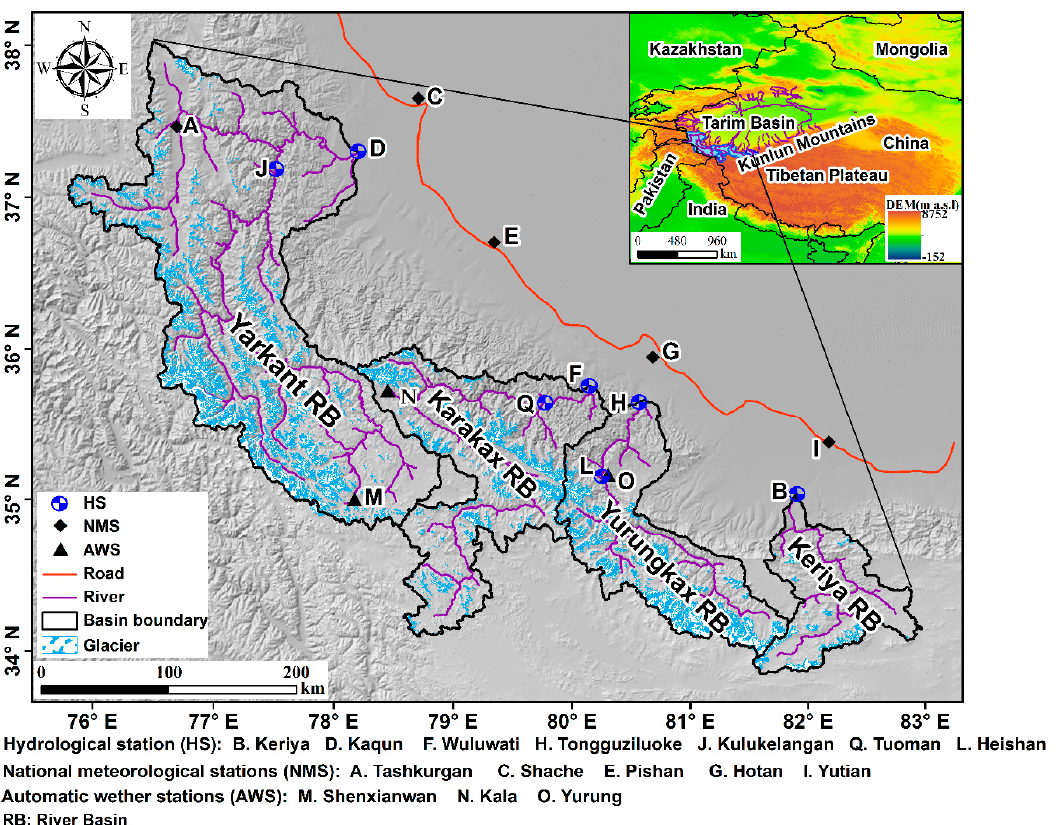
Figure 1. Geographical location of West Kunlun Mountains.